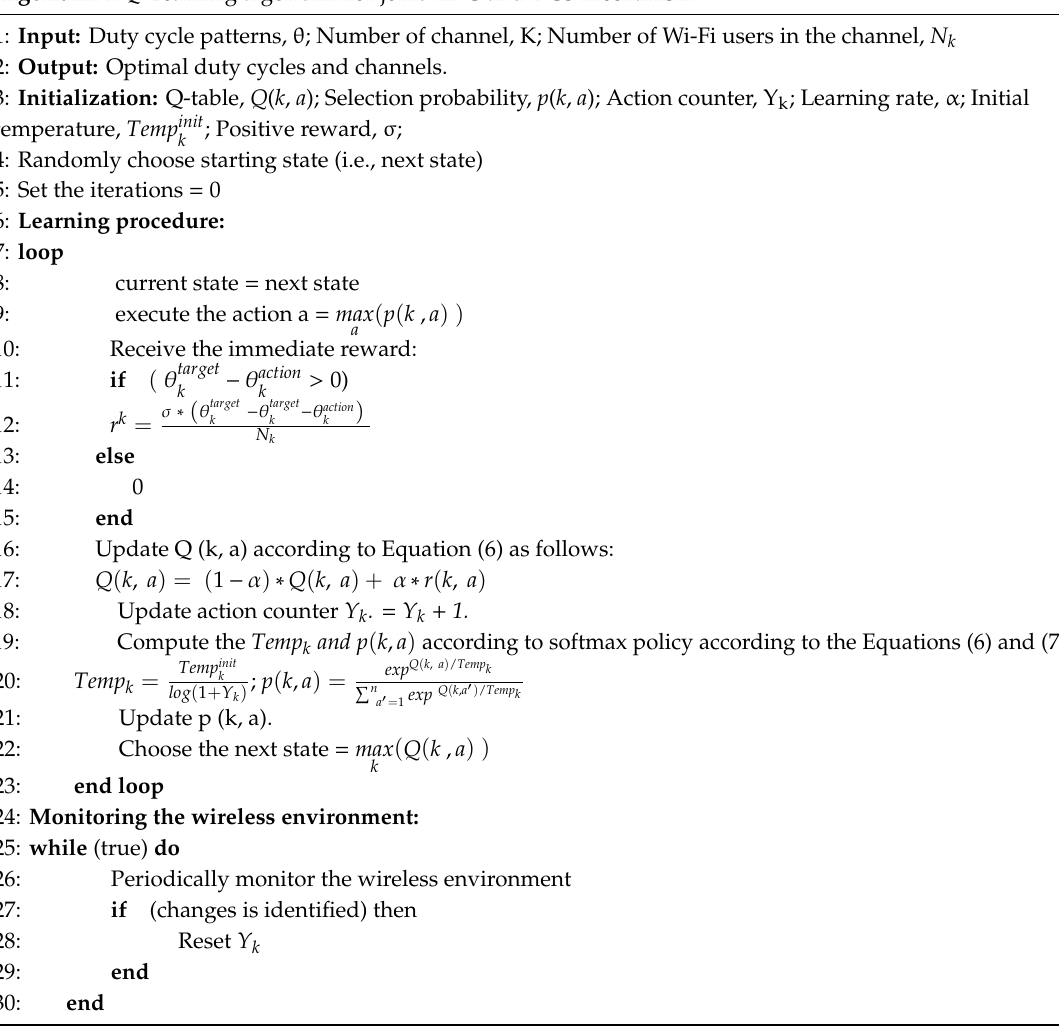
Algorithm 1 Q-Learning algorithm for joint ADC and DCS